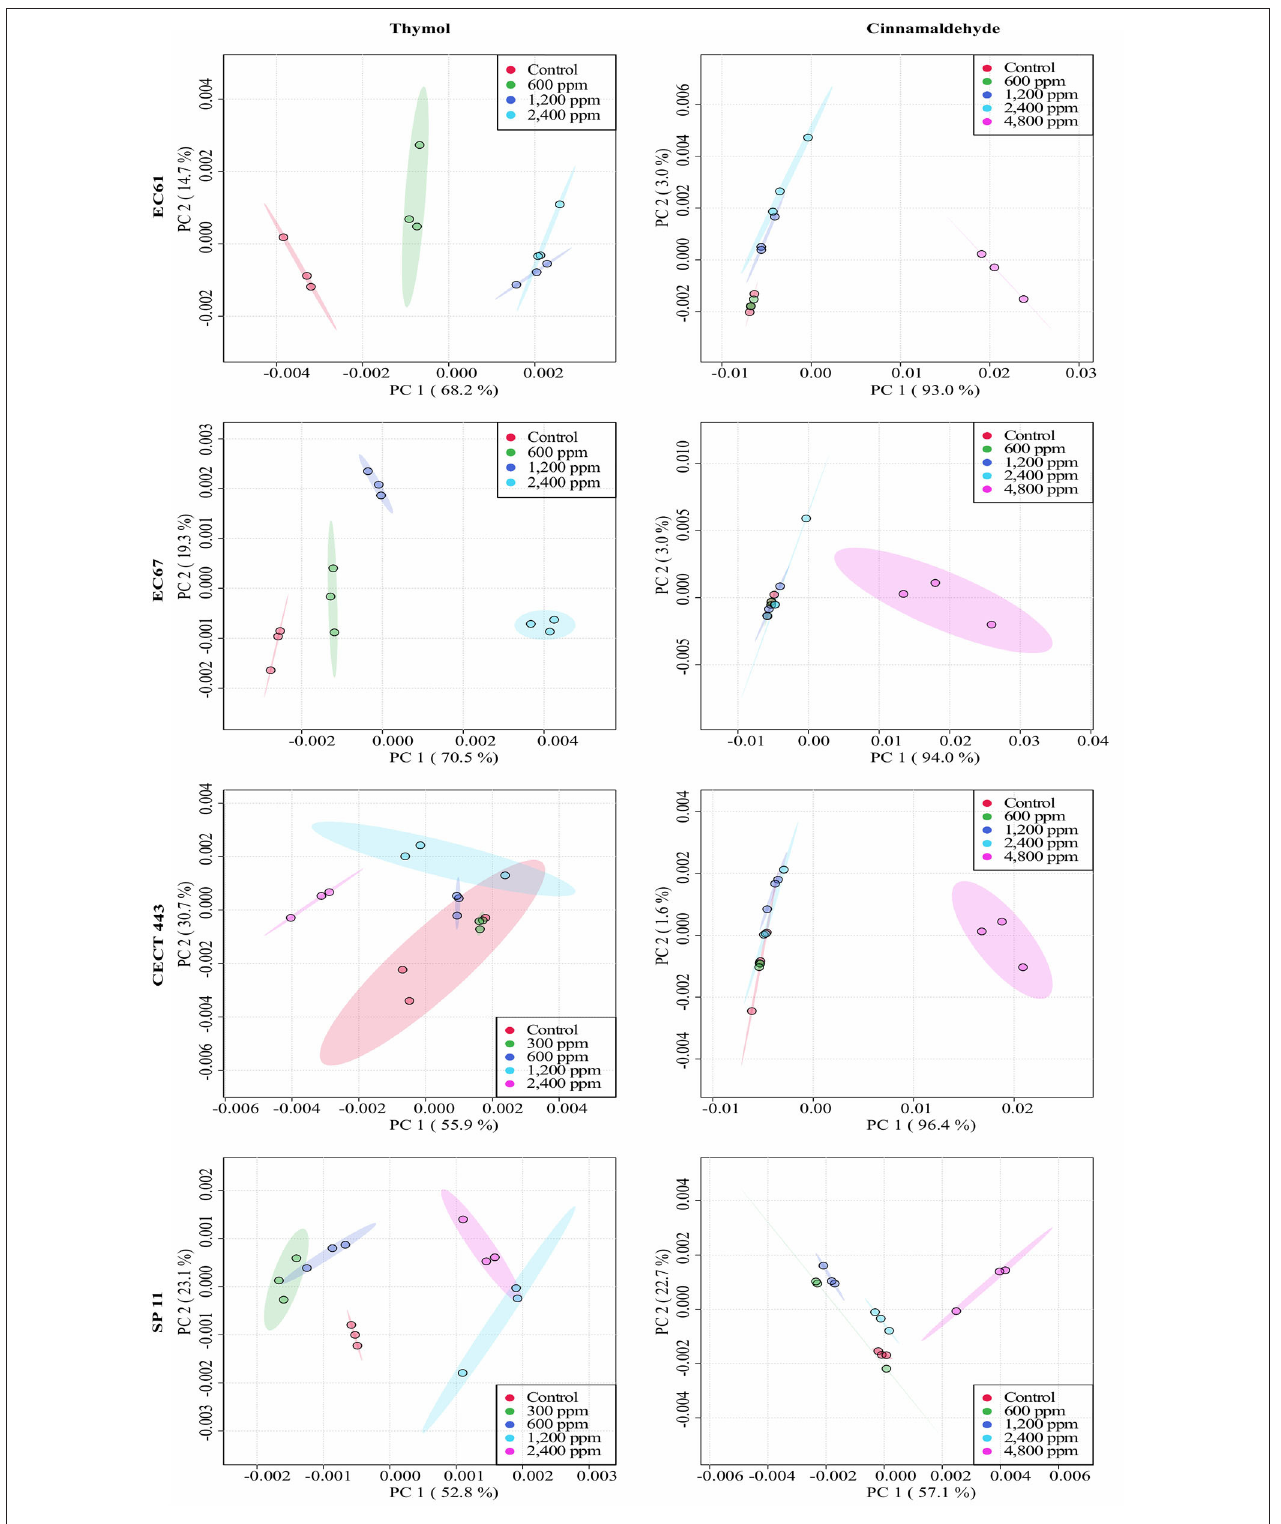
FIGURE 4 | Principal component analysis (PCA) from ASCII data of the FTIR absorbance spectra of the selected windows obtained for each isolate tested of E. coli and S. Typhimurium after the exposure to different concentrations of thymol and cinnamaldehyde (green shaded areas and points, ½ MBC low ; blue shaded areas and points, MBC low ; light blue shaded areas and points, MBC high ; purple shaded areas and points, 2MBC high ) and without compound (red shaded areas and points, control) for 90min at room temperature.